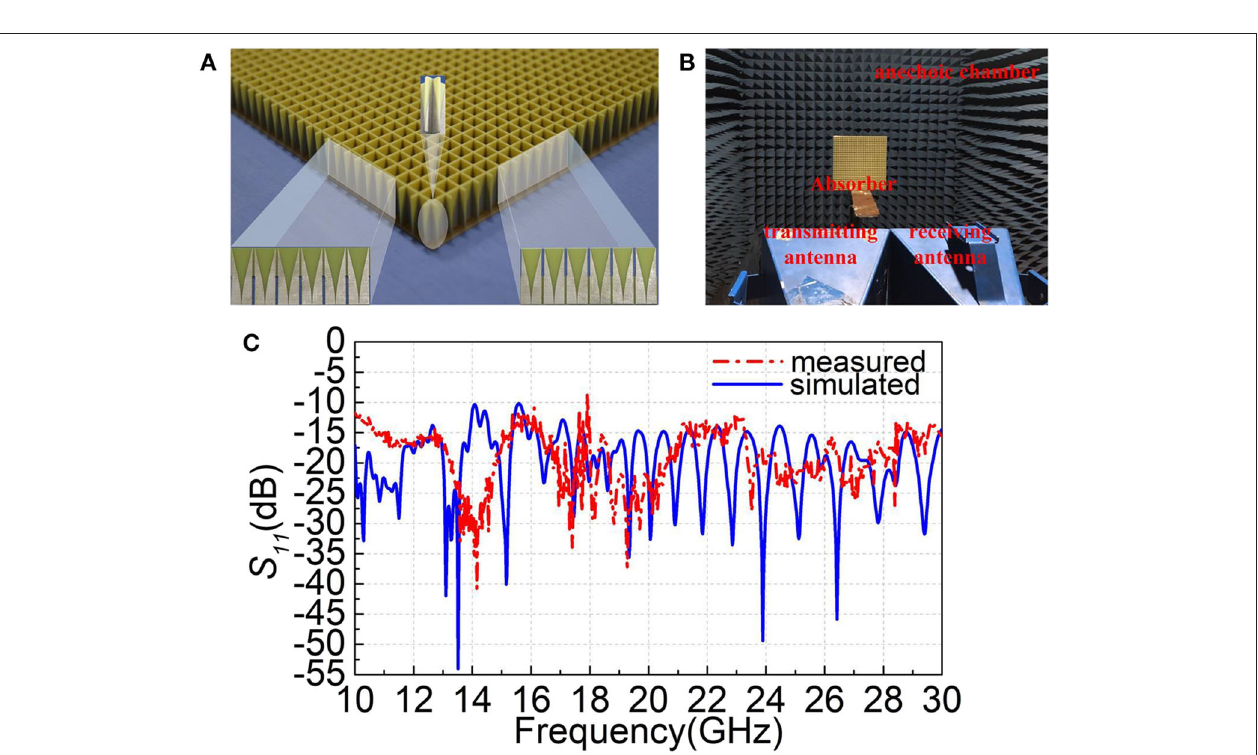
FIGURE 7 | Measurement and results. (A) The photograph of the fabricated APS prototype, (B) the experiment measuring systems, and (C) the measured and simulated results of this